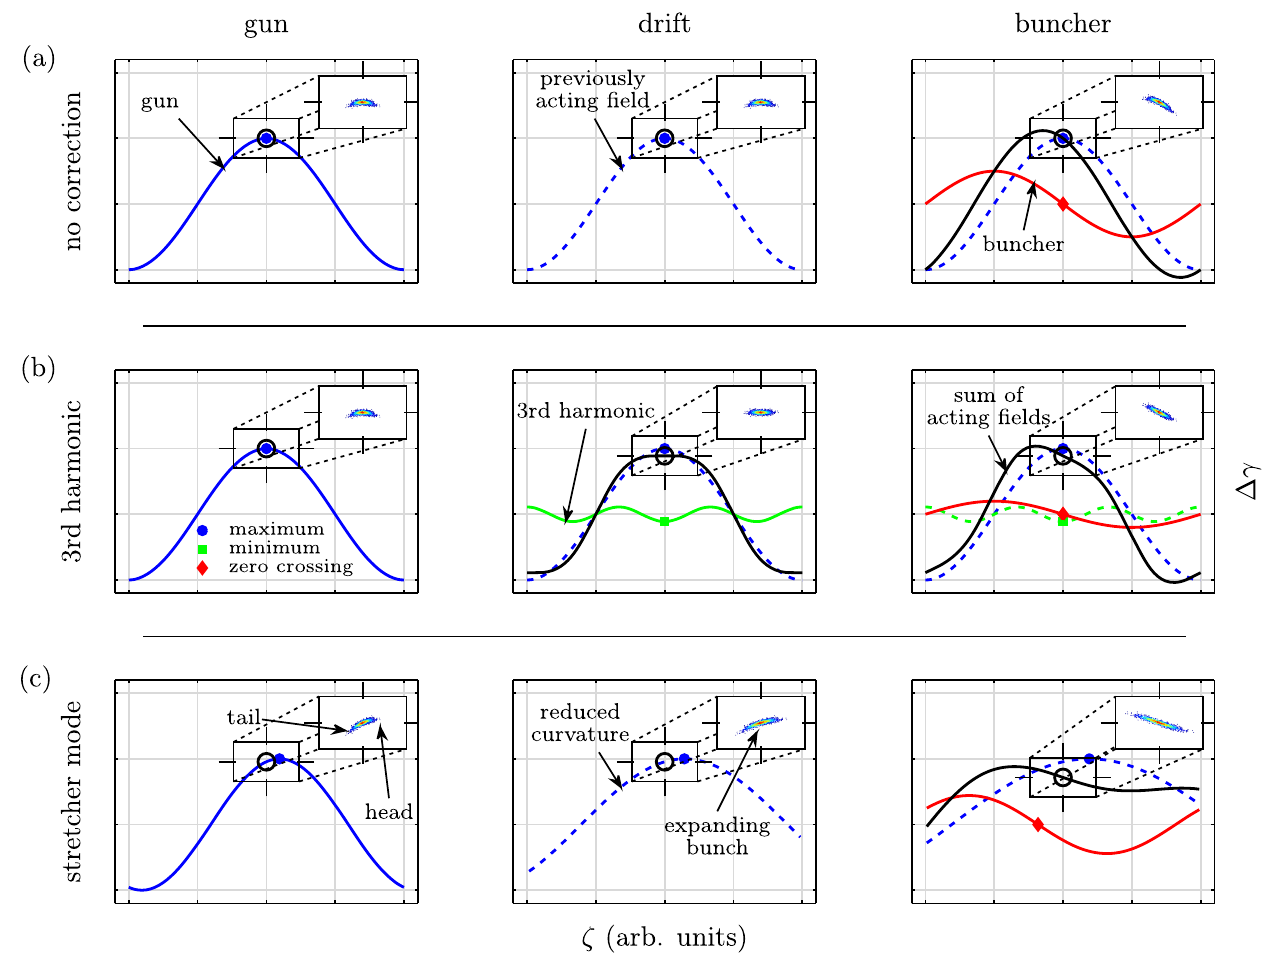
FIG. 1. The basic idea of the stretcher mode concept compared to an uncorrected bunch compression scheme and a third harmonic approach. The plots from left to right show the energy gain/loss, Δ γ , in the respective cavity in the longitudinal phase space of the bunch. Previously acting fields are marked by dashed lines and the black line indicates the sum of all fields that acted up to the respective location. The small insets depict the shape of the bunch in the longitudinal phase space, resulting from an acceleration at the marked phase. Figures (a) depict the case without correction. The bunch acquires the curvature of the finite phase interval it covers in of the gun field — where for simplicity slippage has been neglected. The curved shape is transported and conserved during the drift. After the buncher cavity, a linear correlated energy spread has been imprinted on top by passing at the zero-crossing phase. However, the curvature is still present in the resulting bunching configuration, limiting the maximal achievable compression. In case (b), the introduction of a decelerating third harmonic cavity in the drift between gun and buncher flattens the phase space distributions, resulting in an almost purely linear ζ -dependency of the energy distribution behind the buncher cavity. In (c), the stretcher mode, the bunch is accelerated off-crest in the gun, leading to a controlled expansion within the drift — and an accompanied reduction in the curvature due to the lengthening. Hence, it is possible to find a solution that linearizes the phase space by adding the negative (reduced) curvature in the buncher cavity, while simultaneously adding a linearly correlated energy spread, resulting in a bunch similar to the case of a third harmonic cavity. Please note, in this example only the action of the fields and the linear expansion for the off-crest case are considered. In the full picture higher order effects in the bunch kinetics also need to be explored, as will be seen in the course of this